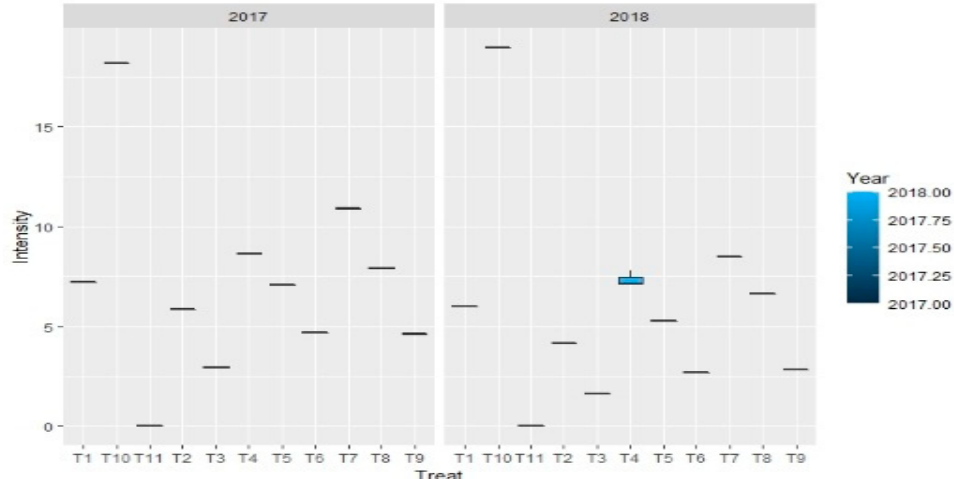
Figure 11. Boxplots depict the impact of systemic fungitoxicants in casing on percent intensity of green mold disease, where T1 = Carbendazim 0.025% conc., T10 = Check I(infested-untreated), T11 = Check II(uninfested-untreated), T2 = Carbendazim 0.05% conc., T3 = Carbendazim 0.1% conc., T4 = Thiophanate methyl 0.025% conc., T5 = Thiophanate methyl 0.05% conc., T6 = Thiophanate methyl 0.1% conc., T7 = Myclobutanil 0.025% conc., T8 = Myclobutanil 0.05% conc., T9 = Myclobutanil 0.1% conc.